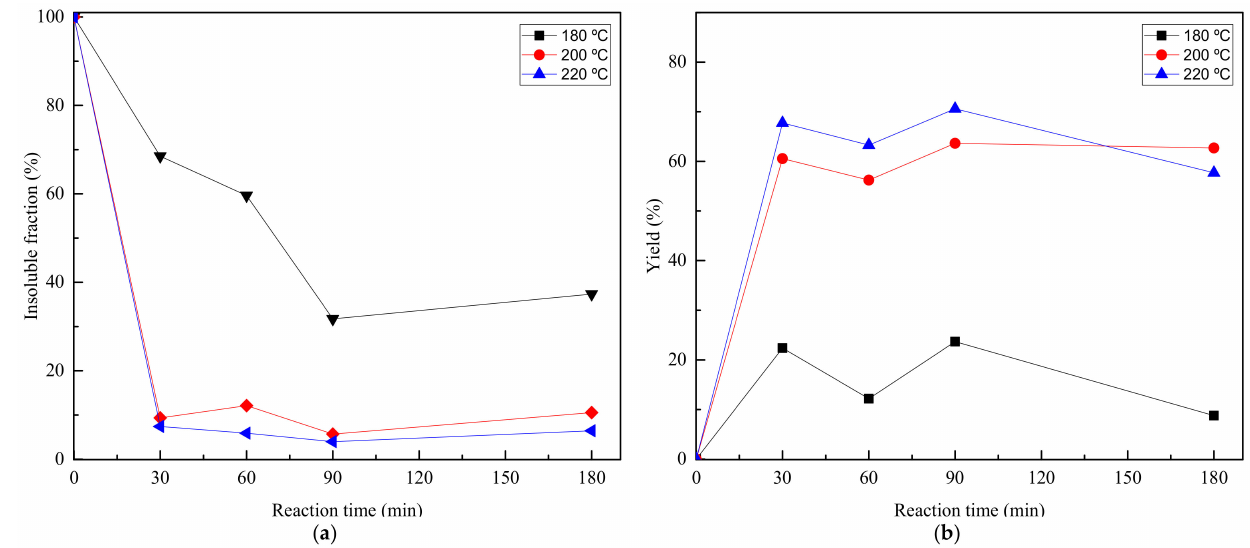
Figure 6. Reaction yield ( a ) and insoluble fraction ( b ) values vs. reaction time at 180, 200 and 220 ◦ C.